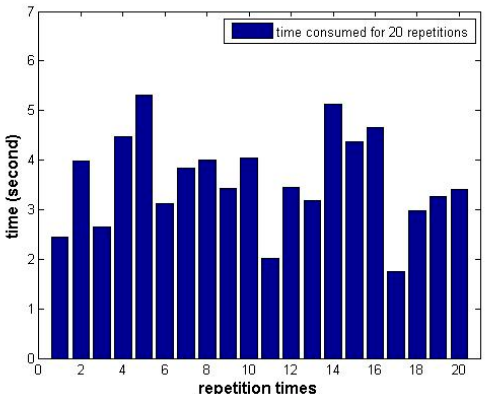
Figure 18. The time consumed for different iteration times of the modified CS.